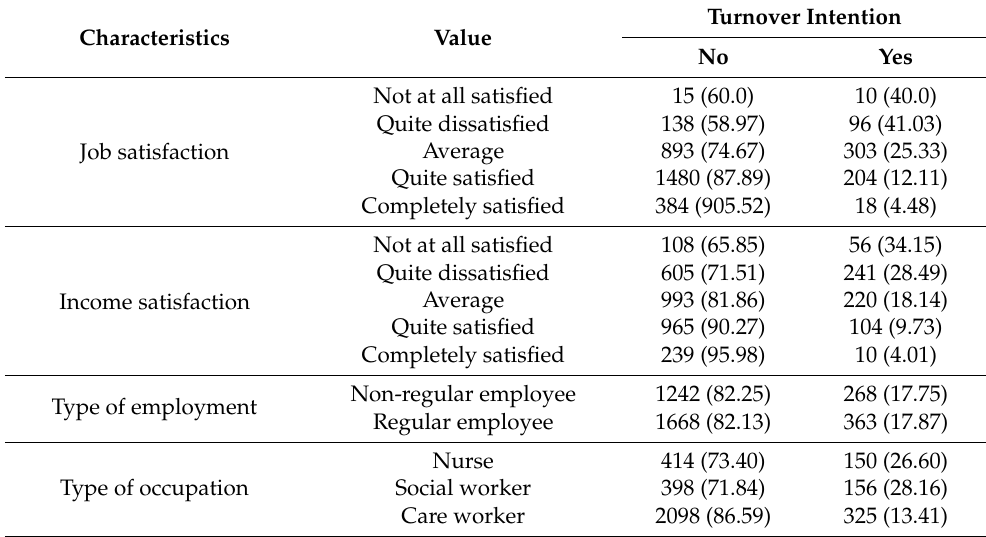
Table 4. Participant characteristics with and without turnover intention ( n = 3541).